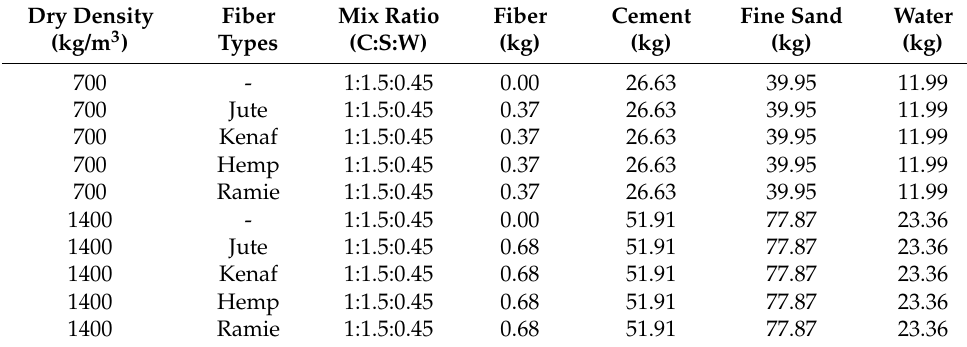
Table 6. Mix proportions of